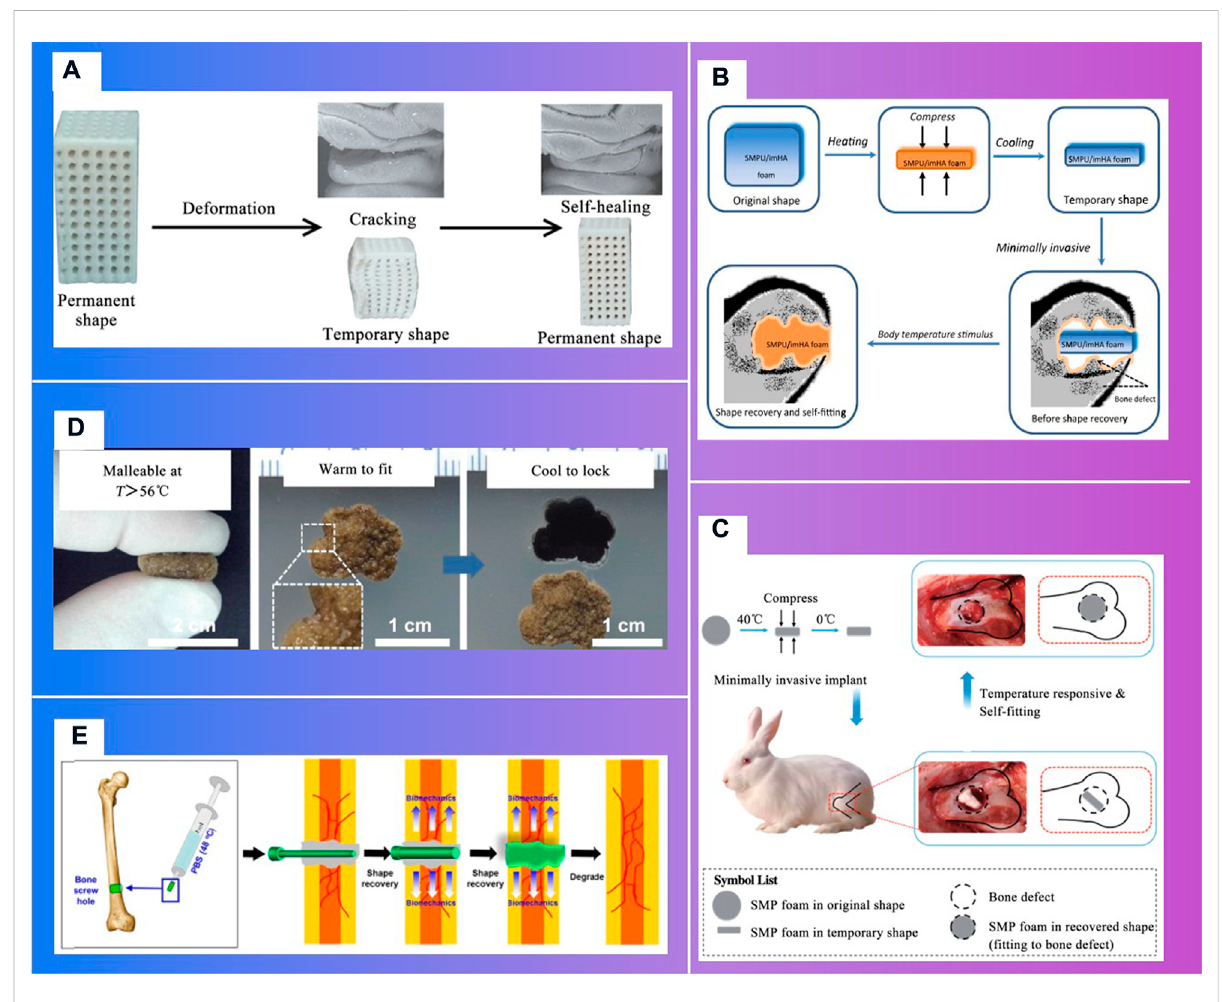
FIGURE 10 Shape memory polymers in bone tissue engineering. (A) t Fixing of a temporary shape of a 3D-printed PLA/HA scaffold through compression (Senatovetal.,2016)(Xieetal.,2017). (B) .Schematicofbody-temperatureresponsiveSMPU/imHAfoamforminimallyinvasivedeliveryinapplication of bone regeneration (Xie et al., 2017). (C) . Schematic of self-adaptive SMP foam as a bone scaffold for bone regeneration (Xie et al., 2018). (D) . Self- adaptive process of polydopamine-coated shape memory porous PCL scaffolds (Zhang et al., 2014). (E) . Schematic illustration showing the application of shape-memory-capable scaffold of the Hap/PLMC nao fi bers (Xie et al.,